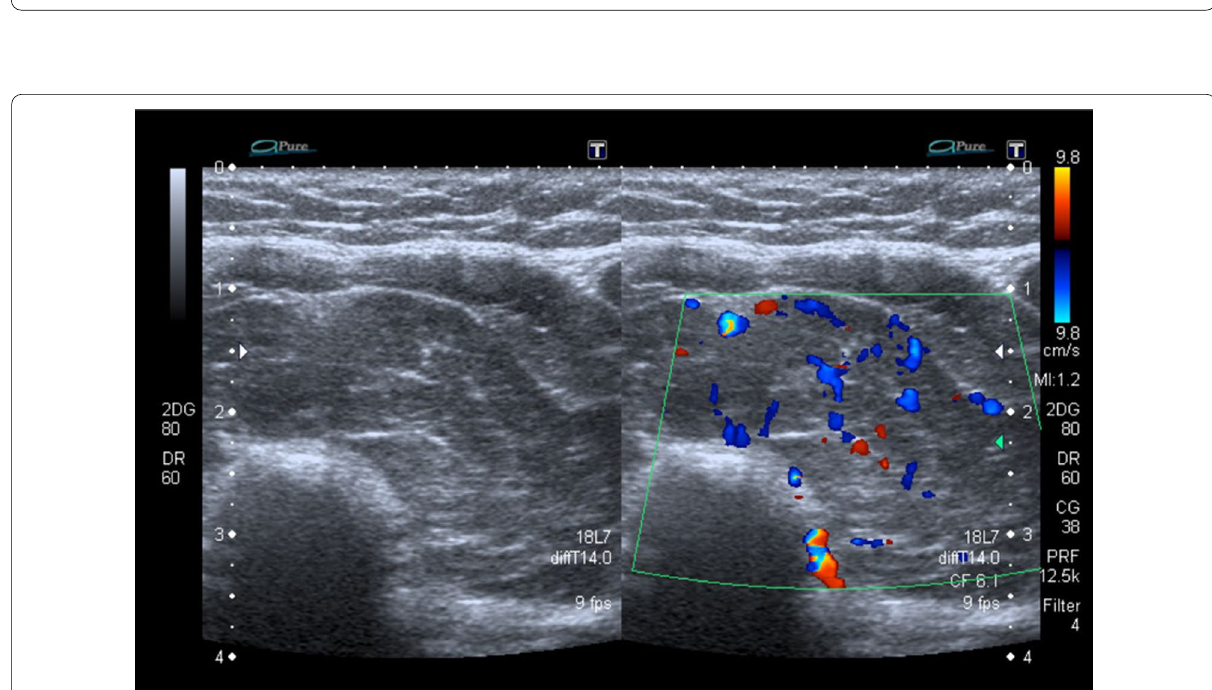
Fig. 2 Male hypothyroid patient, 22-years old. Left thyroid lobe transverse view U/S (gray scale and Doppler) shows parenchymal echogenicity grade 2, septations with undulation of the gland surface (right), mild increased gland vascularity